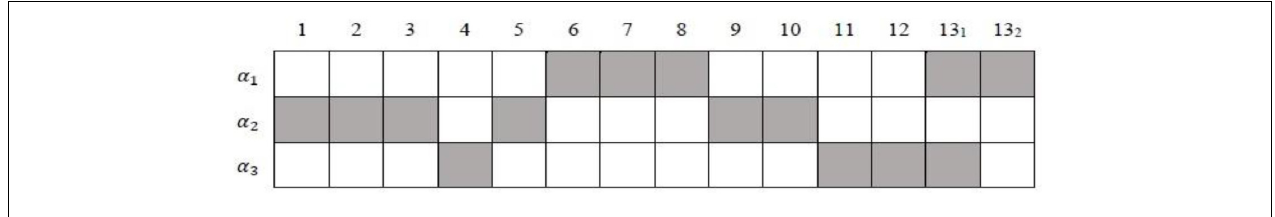
select the data generation model as the better fitting one with a probability larger than